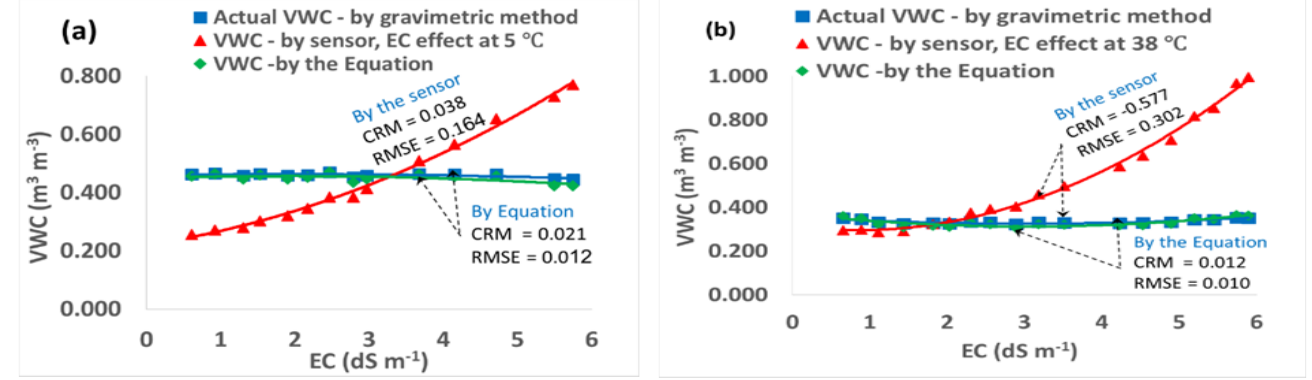
Figure 12. Comparison between VWC values measured by sensors using gravimetric method and proposed L&O correction equation with gradual increase in soil salinity at ( a ) 5 °C and ( b ) 38 °C.